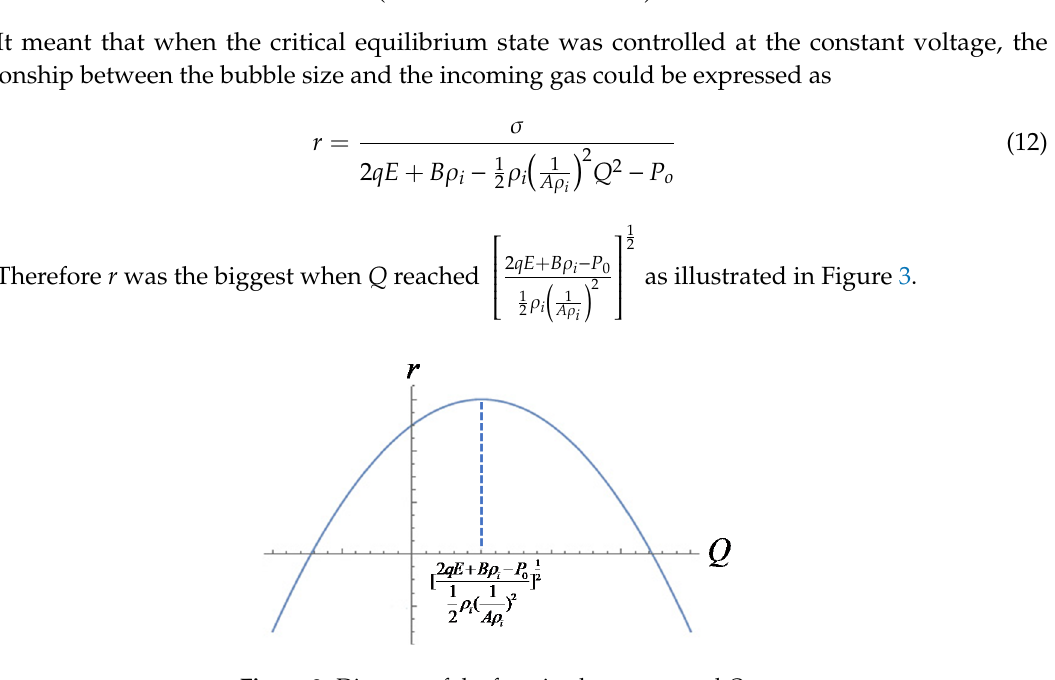
Figure 3. Diagram of the function between r and Q.